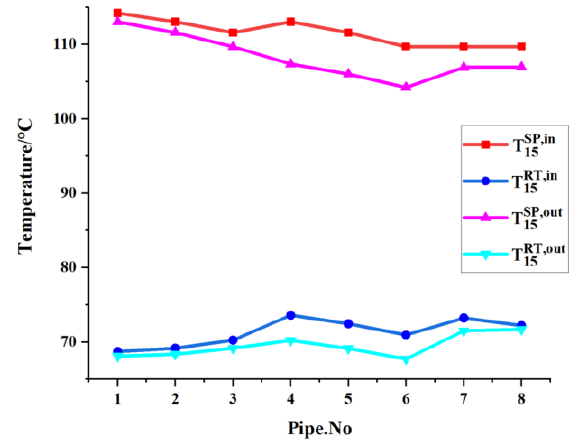
Figure 12. The temperatures of the supply and return system at on-peak times.